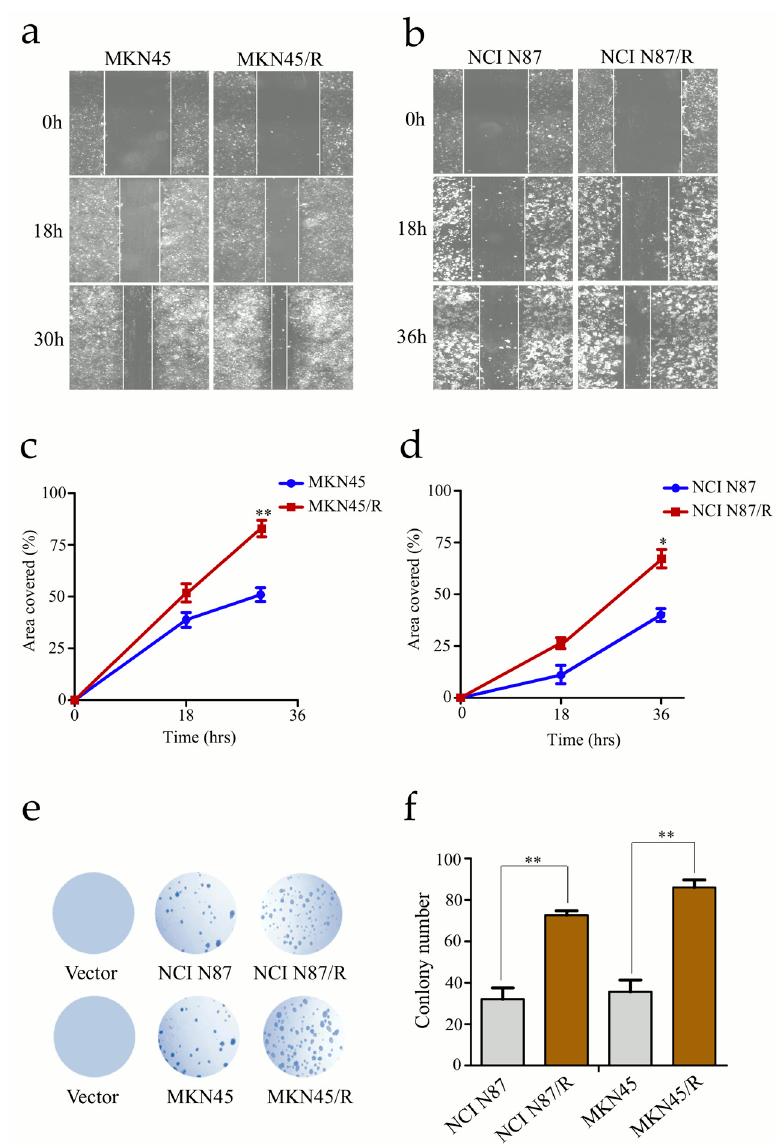
Figure 2. Trastuzumab resistant cells exhibit aggressive migration. ( a , b ) The confluent cell monolayers were wounded by scraping and the closure of the wounded areas was monitored. The images of the wounds were taken at different time points; ( c , d ) Migration activities were analyzed by measuring the distance cells traveled toward the center of the wound; ( e , f ) Colony formation assays were performed and colony numbers were counted and analyzed. All experiments were performed in triplicate. * p < 0.05, ** p < 0.01 vs. controls.